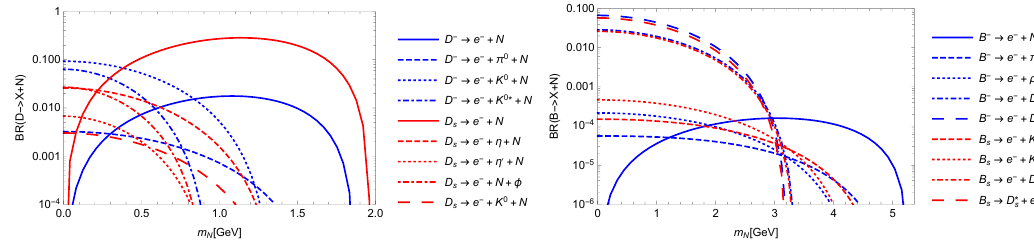
Figure 1 . Branching ratios of sterile neutrino production channels through D (left (cid:12)gure) or B (right (cid:12)gure) mesons in the minimal scenario for (cid:12)nal-state electrons and U e 4 =